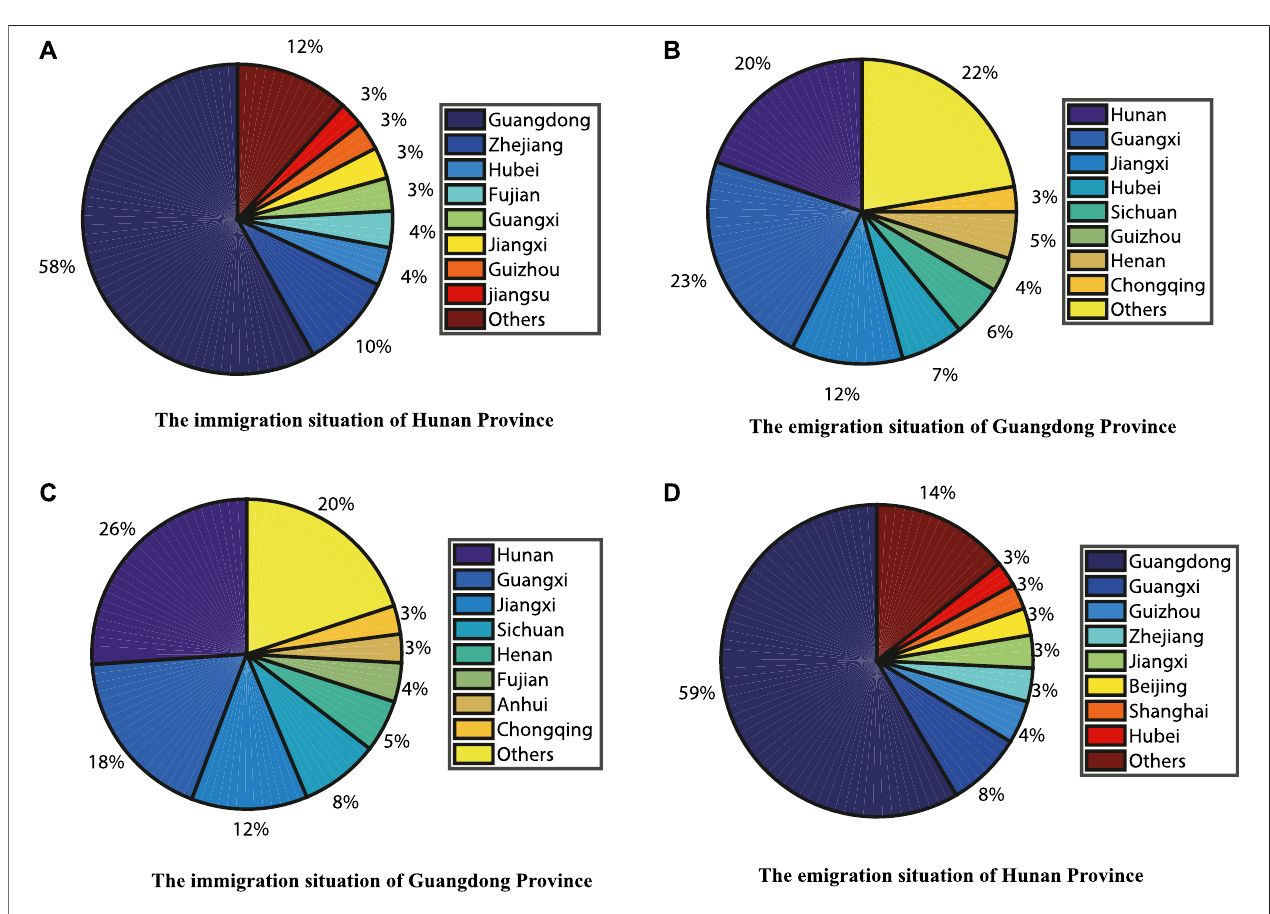
FIGURE 2 | Migration of population in Hunan Province and Guangdong Province [27]. (A) The immigration situation of Hunan Province before the Spring Festival. (B) The emigration situation of Guangdong Province before the Spring Festival. (C) The immigration situation of Guangdong Province after the Spring Festival. (D) The emigration situation of Hunan Province after the Spring